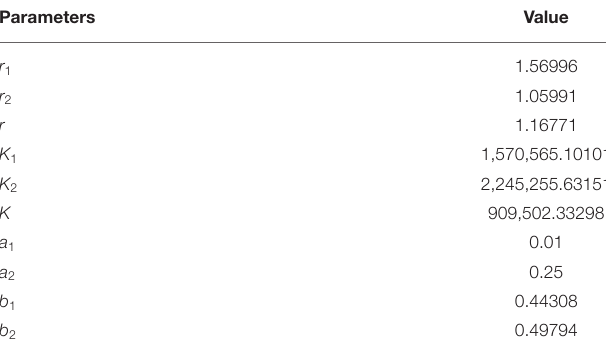
TABLE 6 | Results of regression